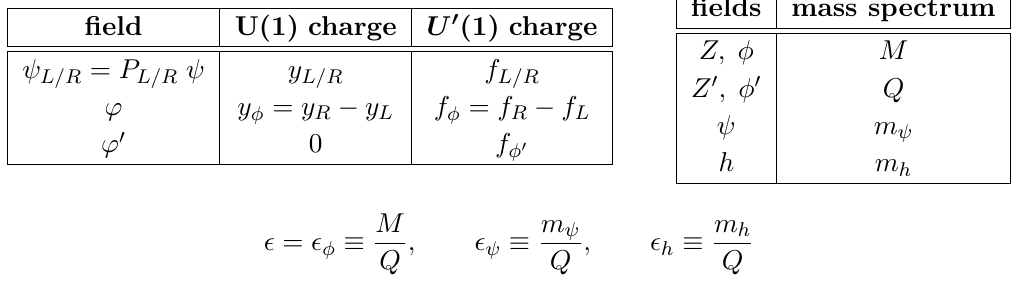
Table 1 . Summary of the main quantum numbers and the mass spectrum for the model given by the Lagrangian density in eqs. (4.1), (4.2),